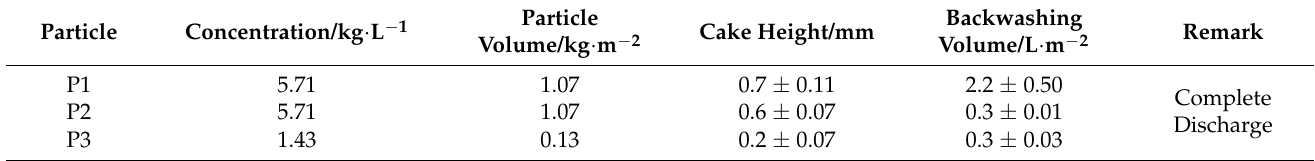
Table 1. Regeneration behavior in a satin fabric with a mesh size of 11 µ m and particle systems based on [8,11]. Particle Concentration/kg · L −